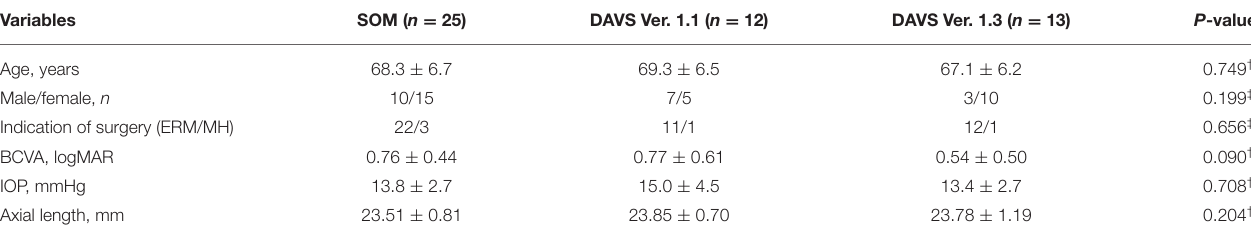
TABLE 2 | Clinical characteristics of standard operating microscope and digitally assisted vitreoretinal surgery groups at baseline.